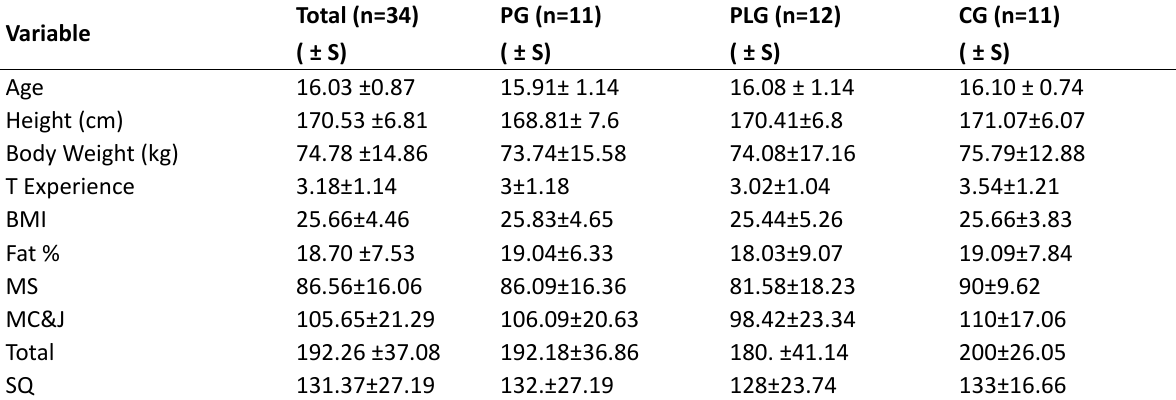
Table 1. Some physical anthropometrical and performance characteristics of subjects